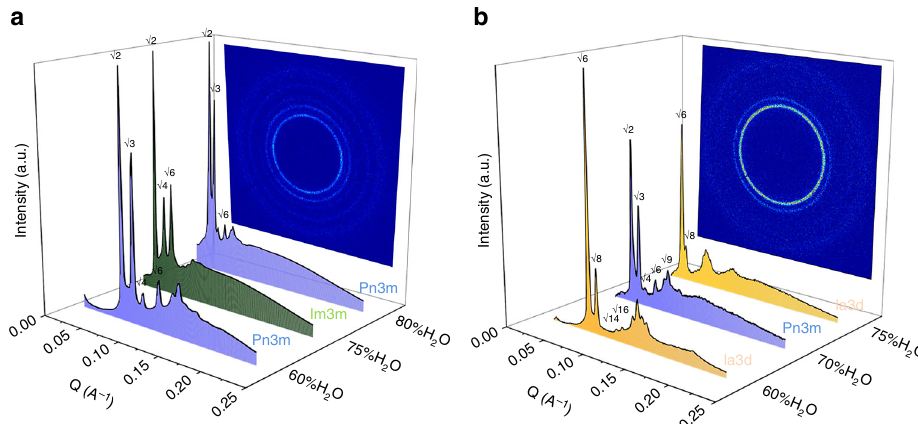
Fig. 2 SAXS pro fi les of the DSPG – MP – water systems. One-dimensional SAXS spectra of scattered intensities vs. scattering vector Q for a 5 wt% DSPG/ MP with 60, 75, and 80% water, and b 8 wt% DSPG/MP with 60, 70, and 75% water at 20 °C. Re-entrant phase behavior is shown here with the different-colored spectra representing the DSPG/MP/water system with Pn3m (blue), Im3m (green), and Ia3d (orange) cubic phases